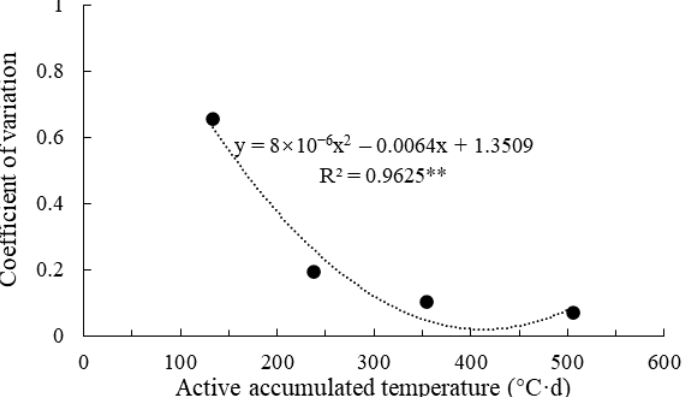
Figure 6. Relationship between the coefficient of variation of winter wheat yield and prewintering active accumulated temperature. Note: The black dotted lines represent the fitted regression trend line. The asterisks (**) indicate the trend’s significance at p < 0.01.